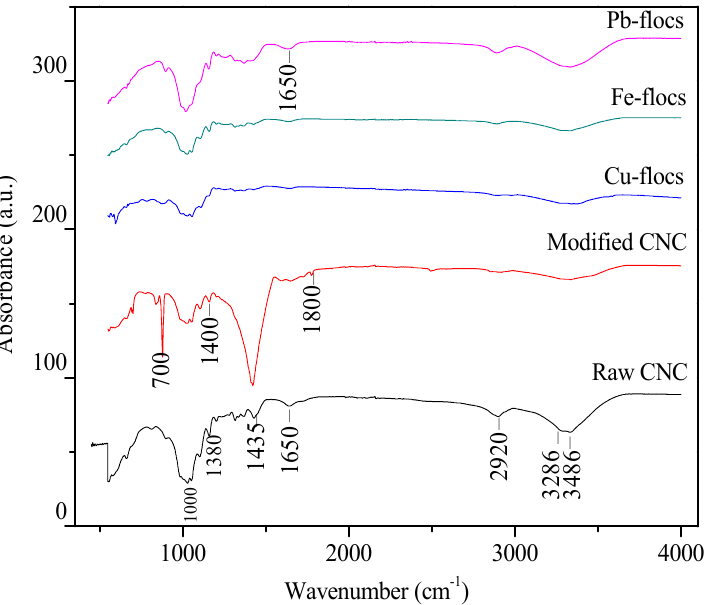
Figure 2. FT-IR Spectra of Raw CNC (unmodified), NaNO 2 /NaHCO 3 modified CNC, Cu-flocs, Fe-flocs and Pb-flocs.